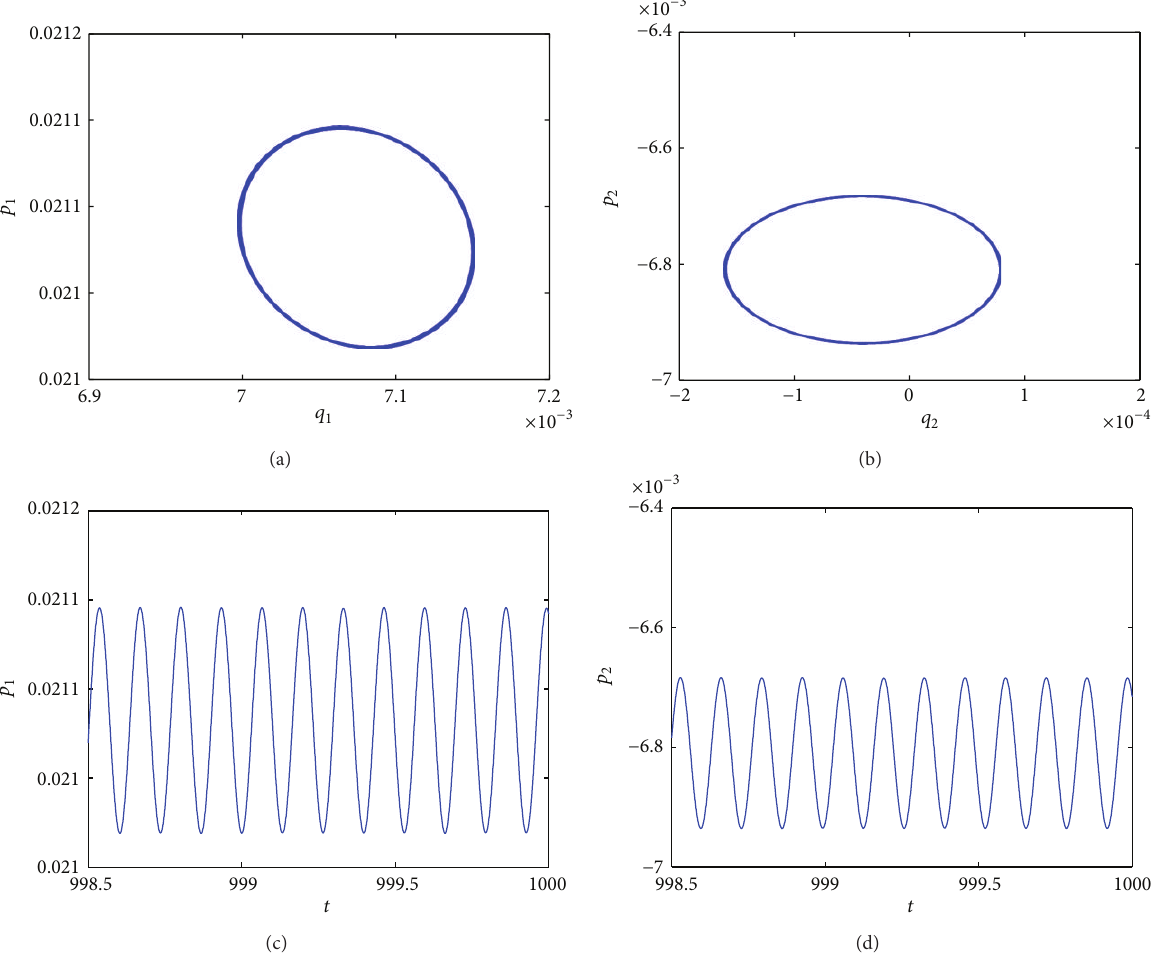
Figure 9: Phase portraits (a, b) and time histories (c, d) in the upper nontrivial stable branch of the frequency response curve of Figure 8 for = 68.2799 , 𝜇 = 0.05 , V = 10 , 𝛼 = 0 , and 𝜎 = 92.39 𝜎 2 1 1